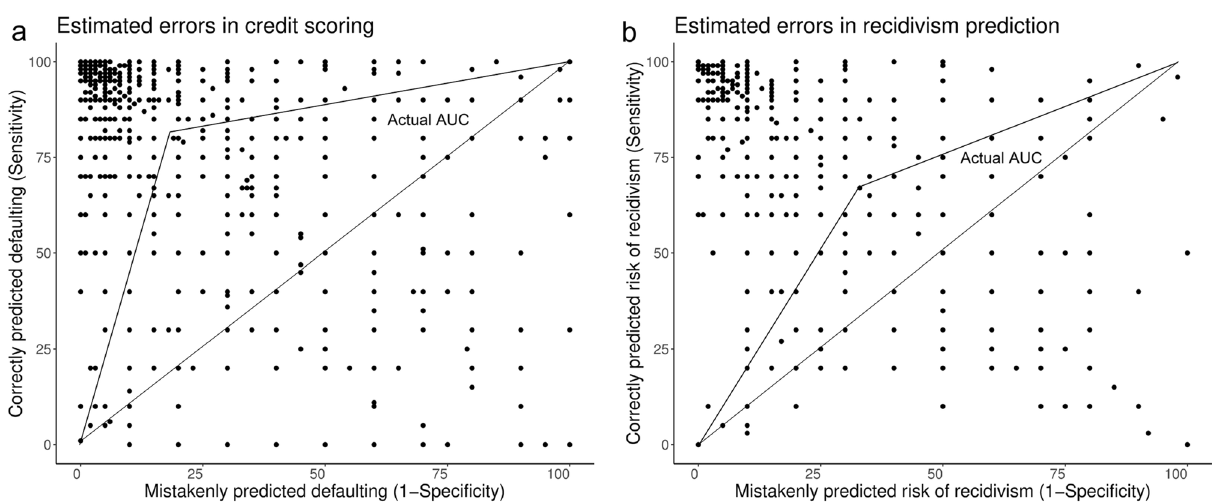
Figure 2. (a,b) Respondents overestimate the accuracy of algorithms for credit scoring and recidivism prediction. The scatterplots show each respondent’s estimates of the false positive rate (1—specificity) and false negative rate (shown as its complement, the sensitivity) in credit scoring ( n = 2740) and in recidivism prediction ( n = 1325). Each point corresponds to one respondent. The triangles frame the areas under the simplified ROC curves for actual credit scoring accuracy (SCHUFA Credit Score algorithm, AUC = 0.81) and for recidivism prediction (COMPAS algorithm, AUC =